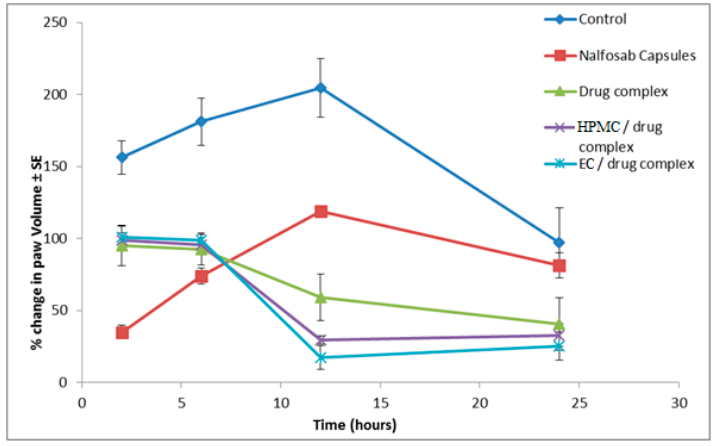
Figure 7. Effect of Nalfosab Capsules, drug complex, HPMC/drug complex and EC/drug complex on the carrageenan-induced acute edema in rat paw.